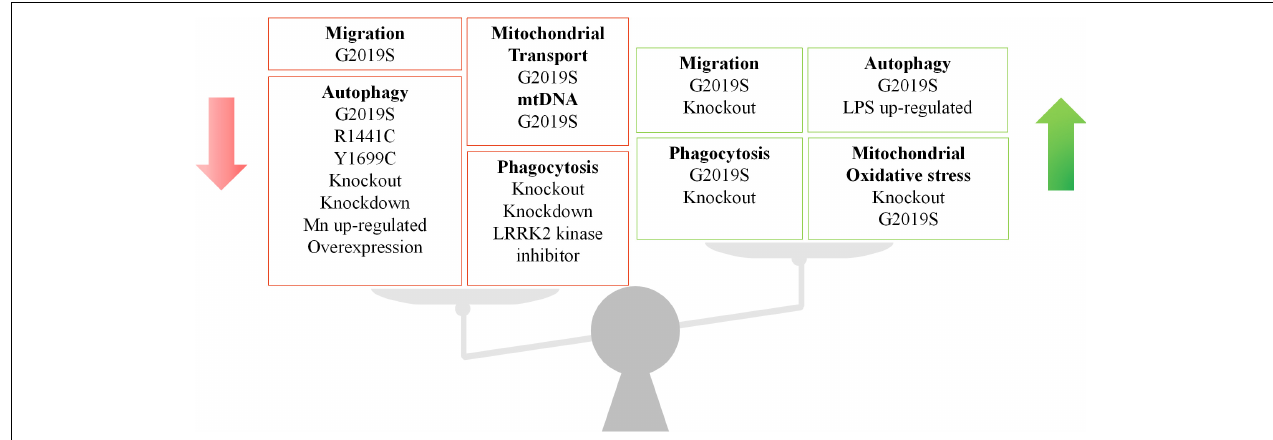
FIGURE 4 | The double-faceted role of LRRK2 in different immune cell types and LRRK2 models. LRRK2 has been shown to regulate migration, autophagy, phagocytosis, and mitochondrial function in immune cells. The regulation role of LRRK2 expression is inconsistent across cell types and models. The green arrow indicates an increase and the red arrow indicates a